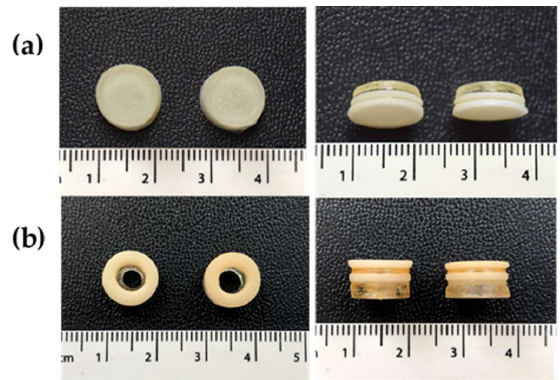
Figure 2. Polypill printlet ( a ) Type I (cylinder shape) and ( b ) Type II (ring shape). The Type III